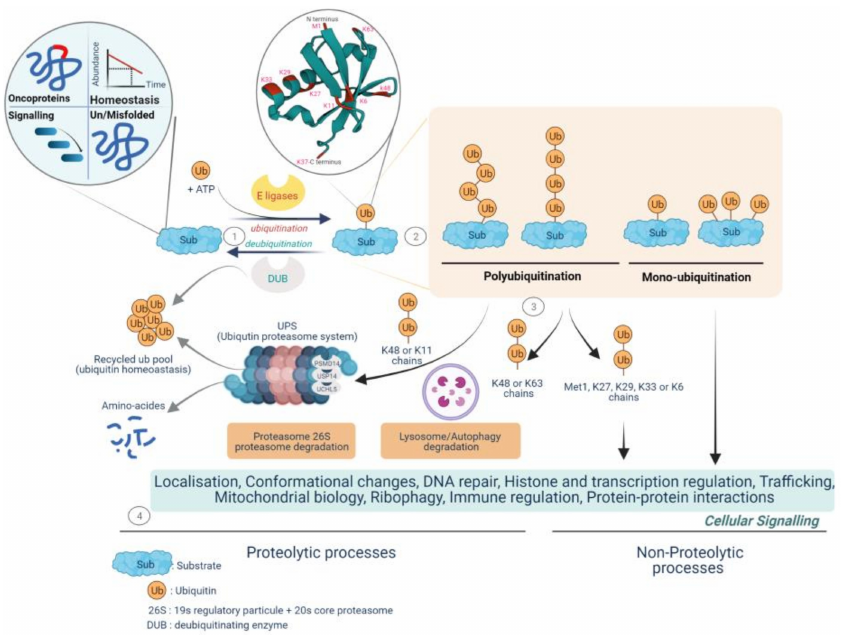
Figure 1. Fate of protein-tethering ubiquitin, a post-translational modification, to proteolytic and non-proteolytic pathways, resulting in specific cellular responses. The ubiquitination process drives protein homeostasis by controlling abundance, temporal and structural integrity, proper localization, and protein non-mutational burden. Called the quality control function, it supports nearly all the cellular functionalities implicated in protein–protein interactions, gene expression, signal transduction cascades, and metabolic pathways. 1 —Protein ubiquitination is performed by the coordinated activity of ubiquitin ligase (E1, E2, and E3 enzymes) and deubiquitinating enzymes (DUBs), called deubiquitination, by antagonizing ligase activity and altering the substrate fate. 2 —Ubiquitin is covalently transferred (isopeptide bonds) between the C-terminal glycine residue (Gly) and substrate lysine residues (Lys) to form monoubiquitinated proteins or can join up with other ubiquitin molecules at the intrinsic N-terminal Met1 residue and/or at the seven intrinsic Lys residues (Lys6, Lys11, Lys27, Lys29, Lys33, Lys48, and Lys63) and may form multi- or poly-ubiquitin chains. 3 —The fate and function of ubiquitinated proteins are affected by the topology and type of ubiquitin- binding. The K48/K11 polyubiquitinated chains have historically been identified as mediating proteasomal degradation of normally folded short-lived proteins and recycling ubiquitin called the ubiquitin–proteasome system (UPS). To date, three deubiquitinases, the metalloprotease PSMD14 and the two cysteine proteases UCHL5 and USP14, have been found to be components of the proteasome 19S regulatory particle implicated in both binding of the ubiquitinated substrate and proteasome activity. 4 —The UPS is a selective and irreversible protein removal mechanism that controls signal transduction, cell division, stress response, and immune adaptation. The degradation of misfolded proteins by the UPS or autophagy is mainly mediated through K48/K63 branch chains. Met1/K63/K29 linkage can modulate various non-degradative processes such as signal transduction, DNA repair, and kinase activation. Lys6-linked chains have been identified as being involved in mitophagy. Monoubiquitination plays various roles in such functions as protein trafficking, DNA repair, chromatin remodeling, and regulation of transcription. (Created with BioRender.com, accessed on 20 June